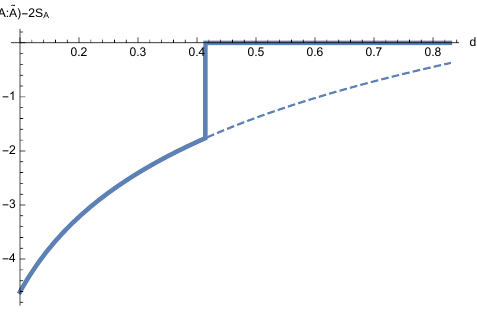
= 1 and the p 6 2 (cid:0)